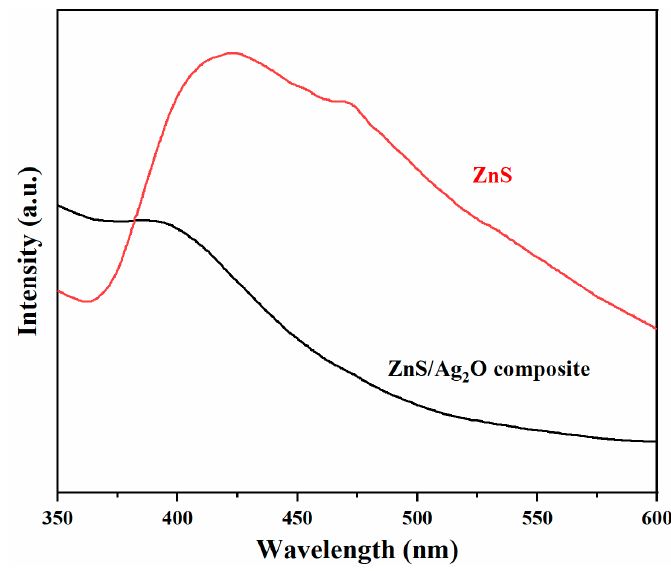
Figure 5. PL spectra of ZnS and ZnS/Ag 2 O composite.